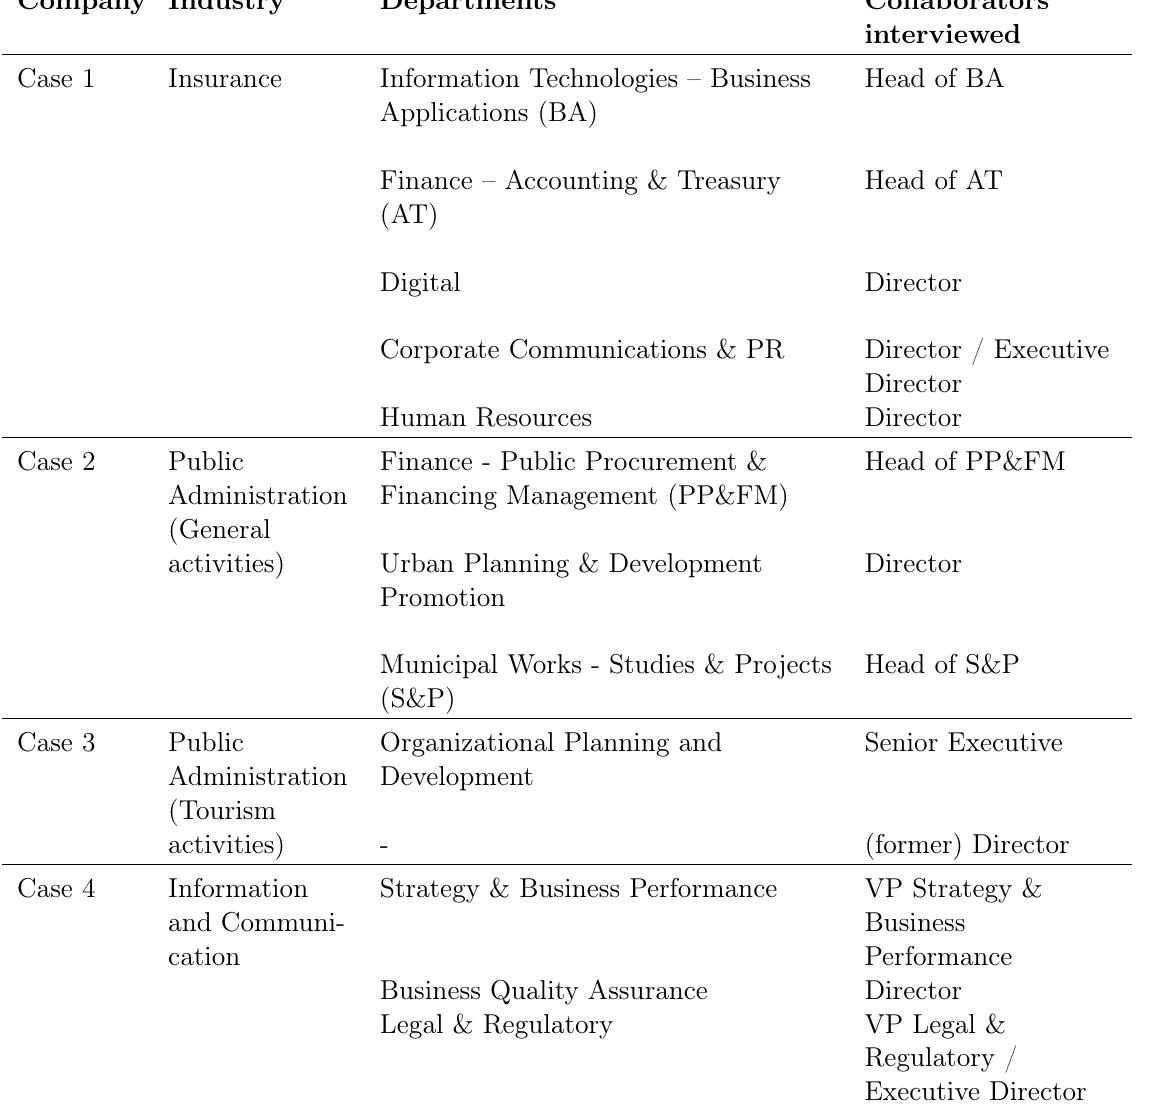
Table 3. Data collection overview. Company